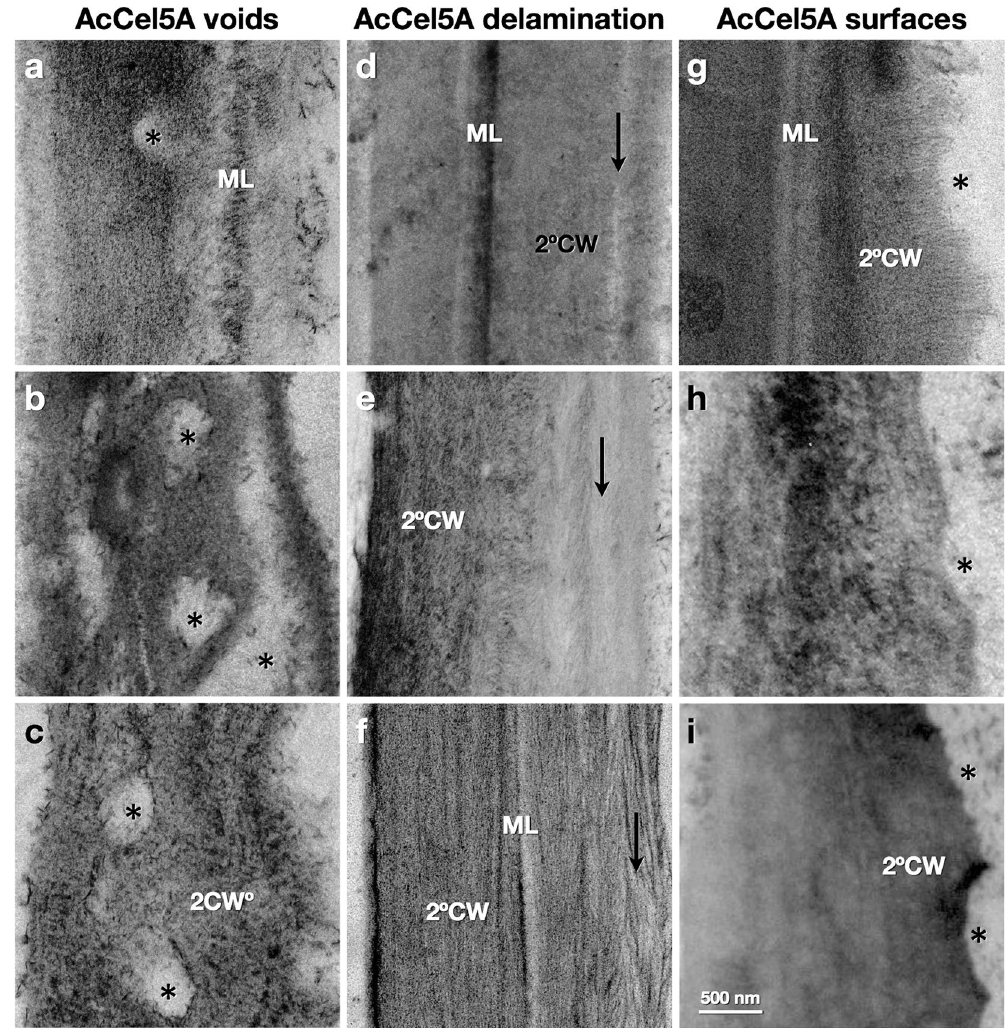
Figure 5. Gallery of TEM micrographs of the AcCel5A expressing plant cell walls of interfascicular fiber cells display examples of cell wall disruption morphologies. The tissue and cell orientation is the same as in Fig. 4 with sections transverse to the growth axis of the plant. These micrographs reveal some of the more extreme examples of voids or clearing zones ( * , a–c ), wall delamination (arrows, d–f ), and irregular, scalloped wall surfaces ( * , g–i ). ML-middle lamella, 2°CW-secondary cell wall. The e AcCel5A data is from line